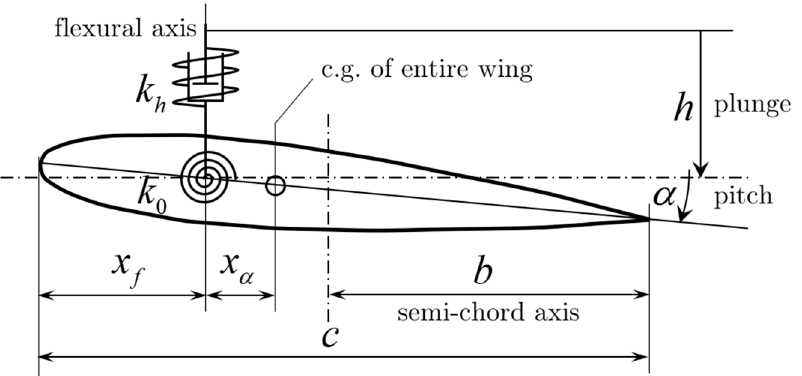
Figure 9. The numerical model: a plunge–pitch wing section, where freeplay nonlinearity is intro- duced in the pitch degree of freedom (DoF).